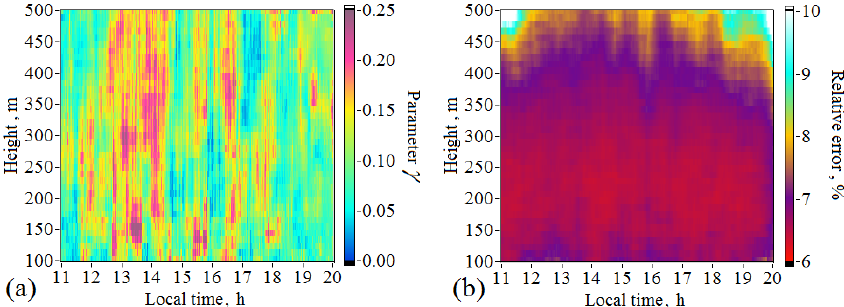
Figure 11. Time–height plots of the parameter γ (a) and the relative error of estimation of the dissipation rate (b) obtained from measurements by the Stream Line lidar on 22 July